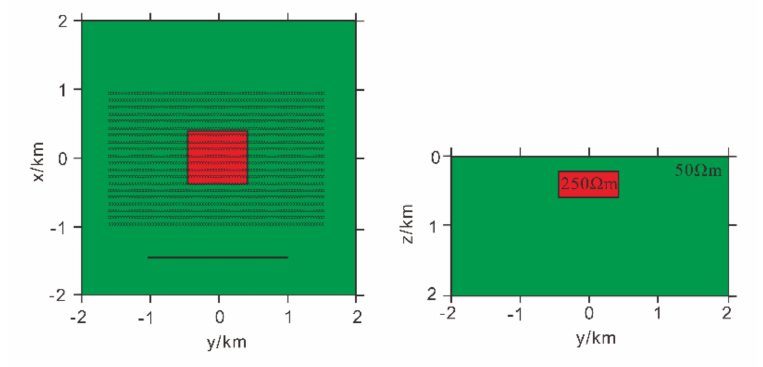
Figure 4. Schematic diagrams of the transceiver and the position of the